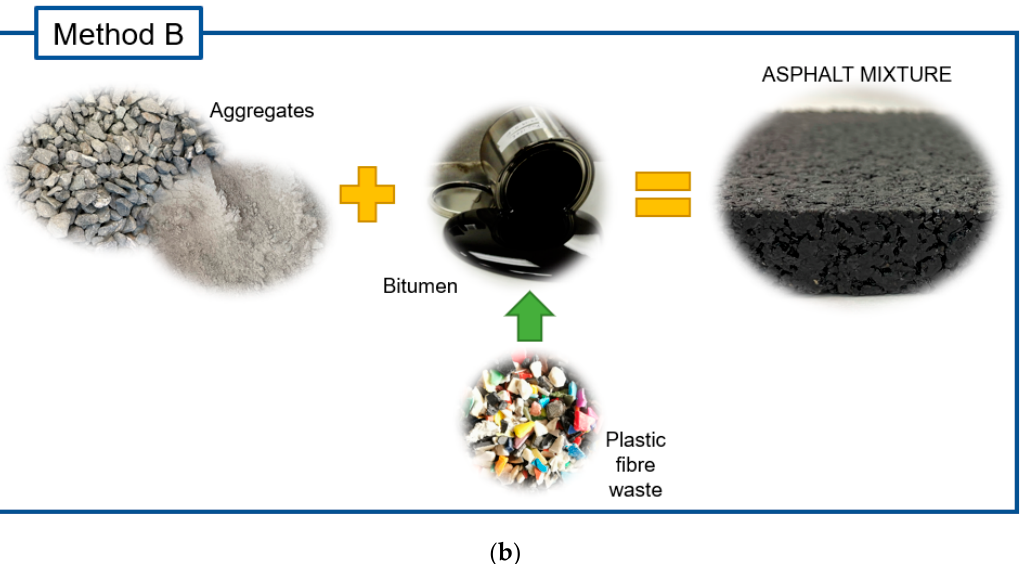
Figure 3. Methods for adding residual plastics to dry mix processing. ( a ) plastic over aggregates ( b ) plastic over bitumen.